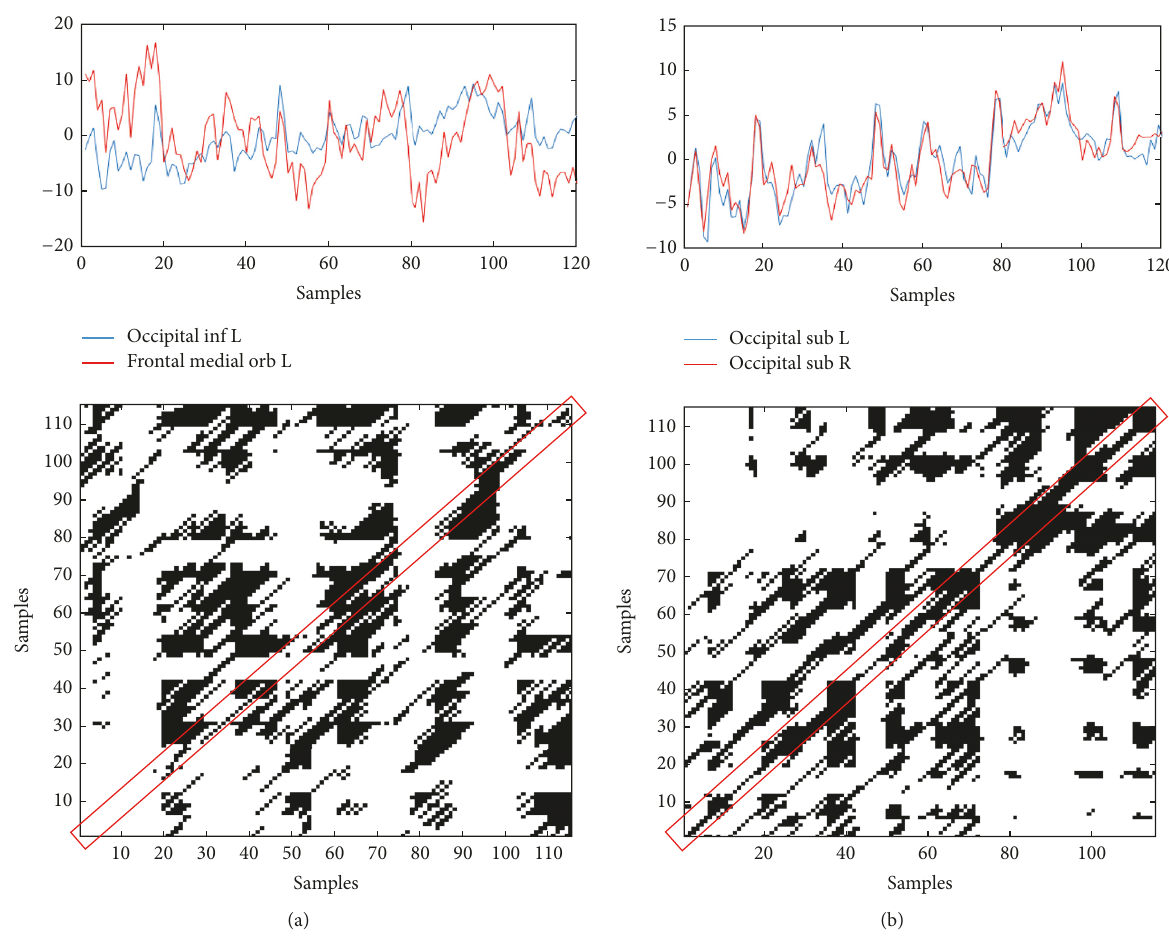
Figure 1: Pairs of fMRI time series and their CRPs for (a) occipital inferior L and frontal medial orbital L (SYNC = 0.05); (b) occipital superior L and occipital superior R (SYNC = 1).